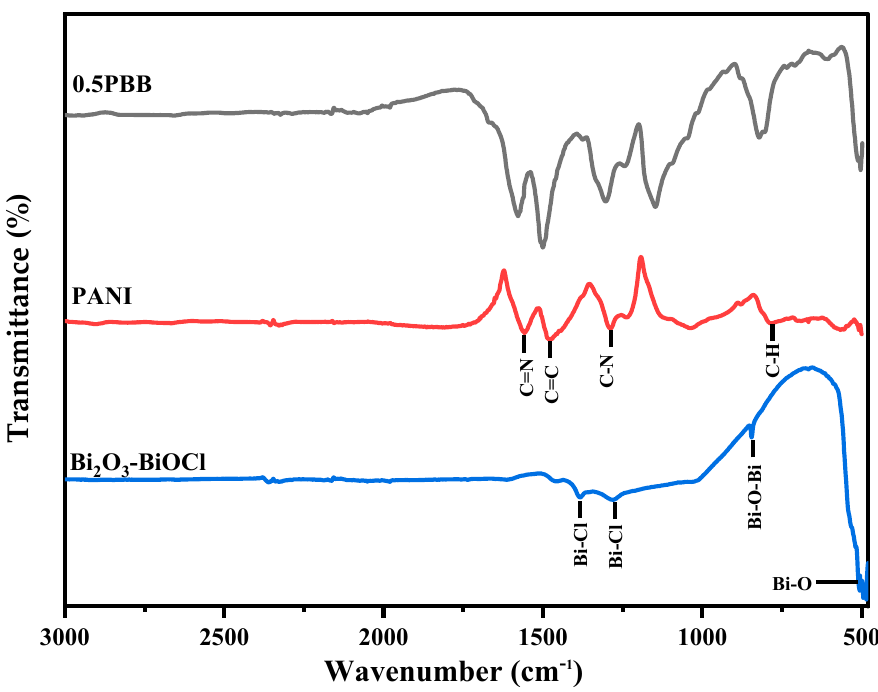
Figure 2. FTIR spectra of Bi 2 O 3 -BiOCl, PANI, and 0.5PBB. SEM and TEM techniques examined the morphologies of PANI, Bi 2 O 3, and 0.5PBB. The obtained images are shown in Figures 3, 4, S3 and S4 (in the SI). The TEM and SEM images of Bi 2 O 3 exhibited a spindle-like shape of about 100 nm in size, as shown in Figures 3a and S3a–c. Moreover, the EDS analysis and the O and Bi elemental mapping of Bi 2 O 3 are reported in Figure S3d–f. The TEM image of PANI (Figure 3b,c) showed the typical globular-like morphology, a characteristic of this polymer, as previously observed [22].